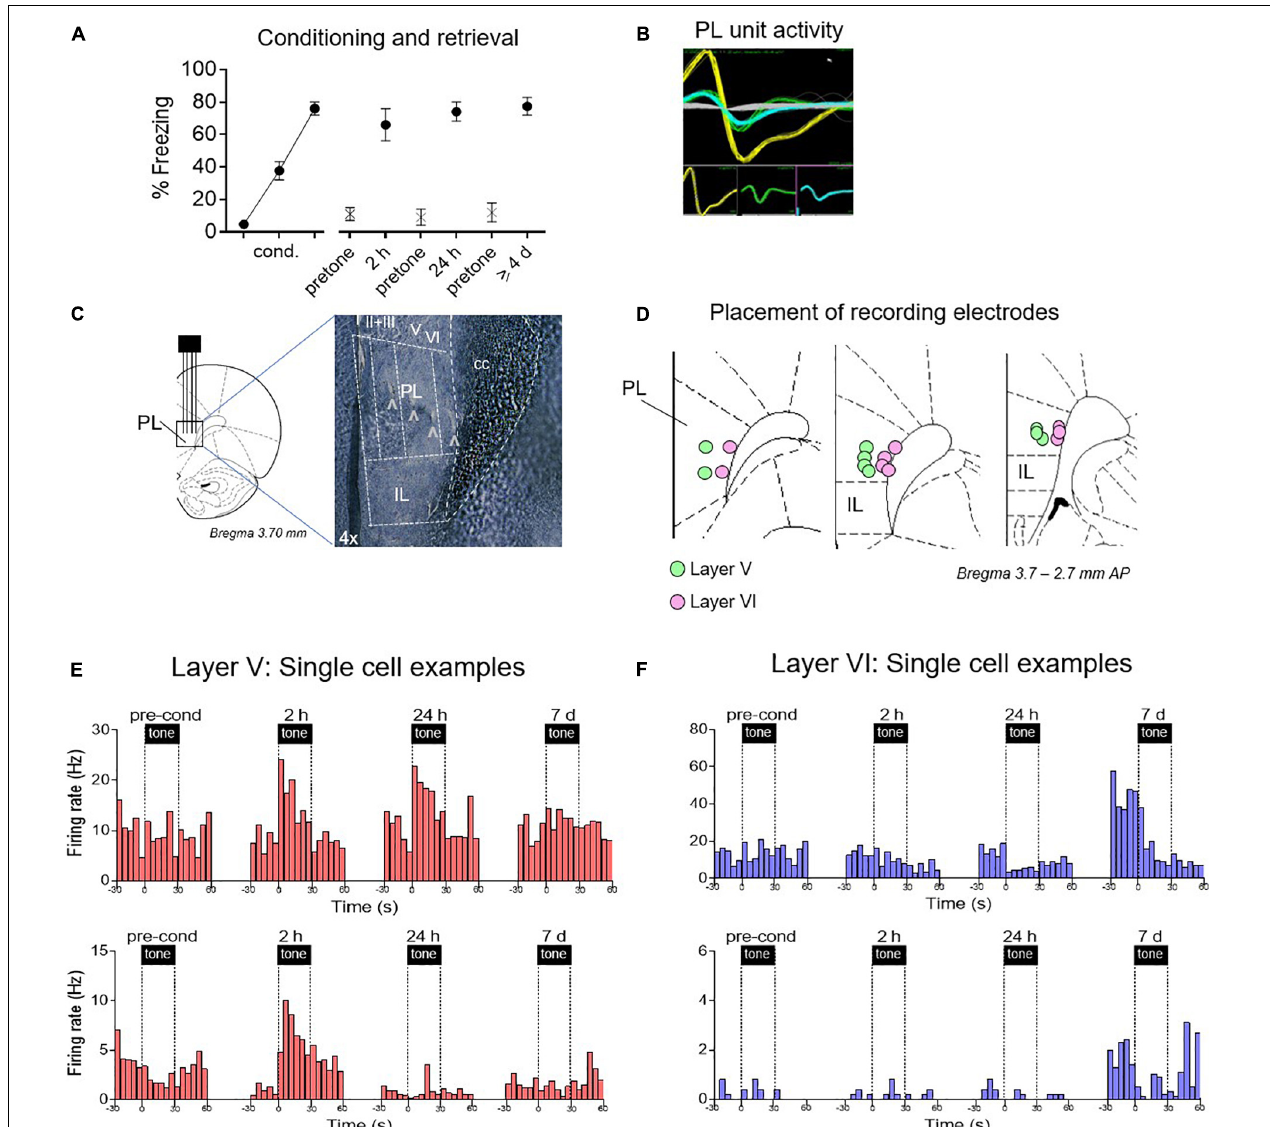
FIGURE 2 | Examples of time-dependent changes in conditioned responses of PL neurons. (A) Freezing across retrieval tests (blocks of two trials). After electrode implantation, PL neurons were recorded before conditioning, and 2 h, 24 h, and ≥ 4 days after conditioning. (B) Examples of discriminated unit waveforms. (C,D) Placement of silicon probe or wire array electrodes in either layer V or layer VI of PL. (E) Peri-stimulus time histograms (PSTHs) of representative PL neurons Layer V in red, showing significant excitatory responses. (F) PSTHs of representative PL neurons in Layer VI in blue, showing significant inhibitory responses.